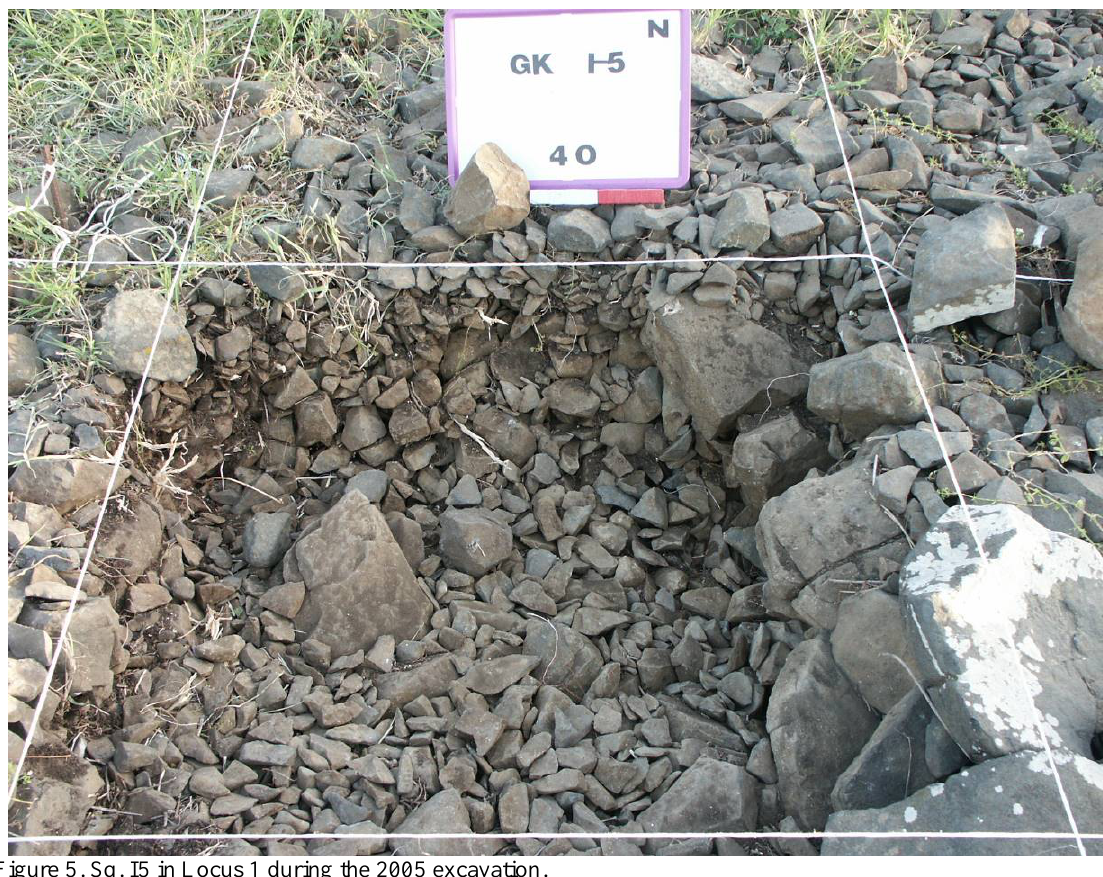
Figure 5. Sq. I5 in Locus 1 during the 2005 excavation.